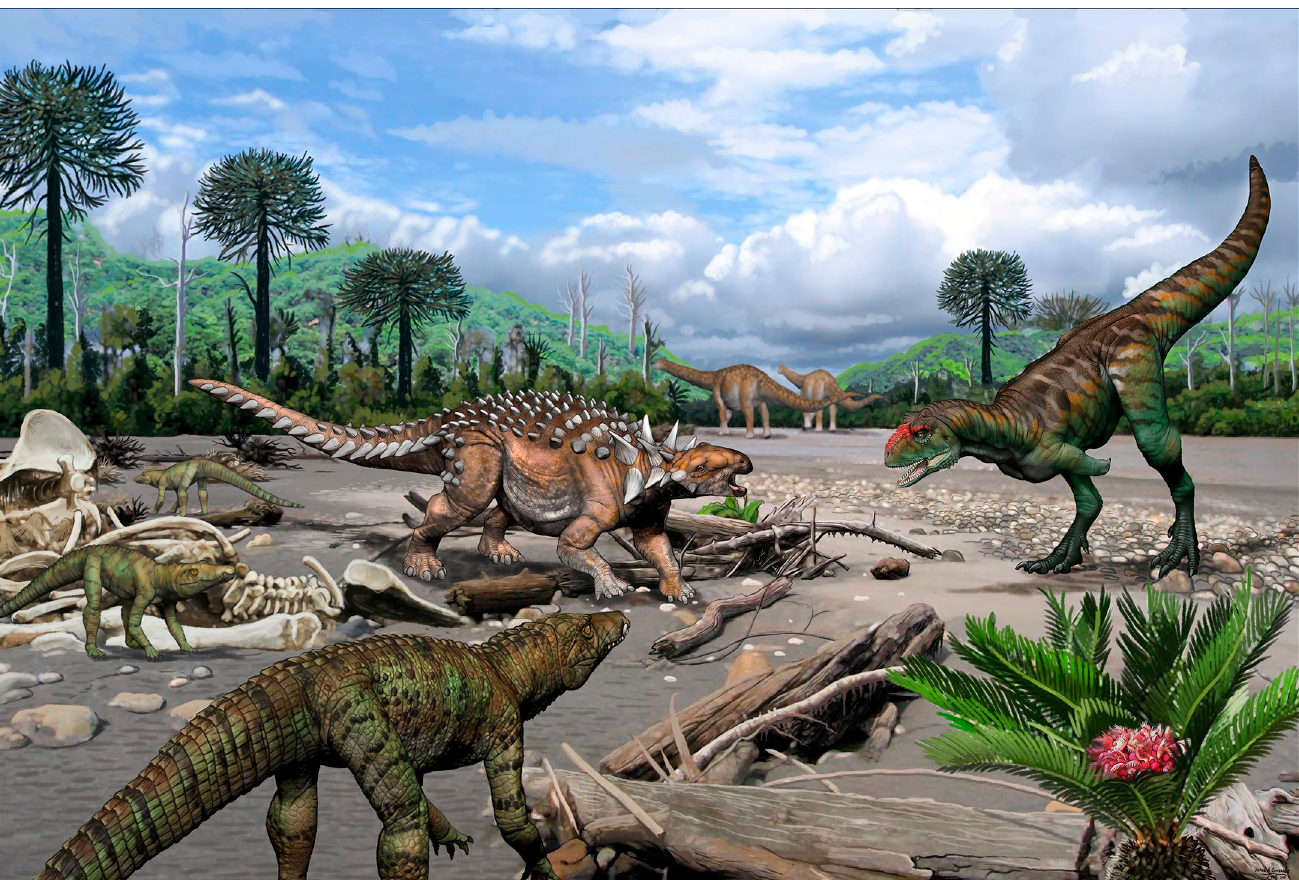
Fig 7. Paleoambiental reconstruction of Cerro Fortaleza locality (Cerro Fortaleza Formation) showing the coeval dinosaurs and peirosaurid notosuchians described in the present study (and right below is Zamuneria ). Illustration by J. Gonza´lez.